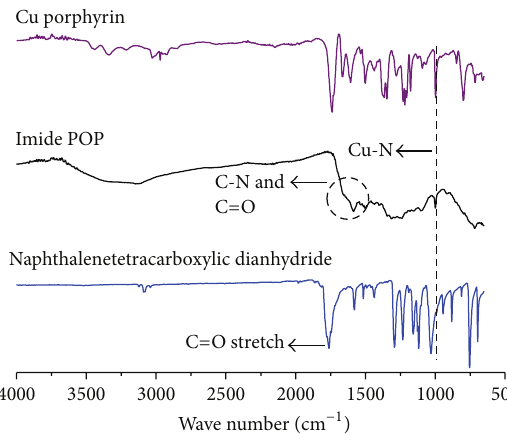
Figure 1: IR spectra of PyP, meso -tetraphenylamino porphyrin, and naphthalenetetracarboxylic dianhydride.